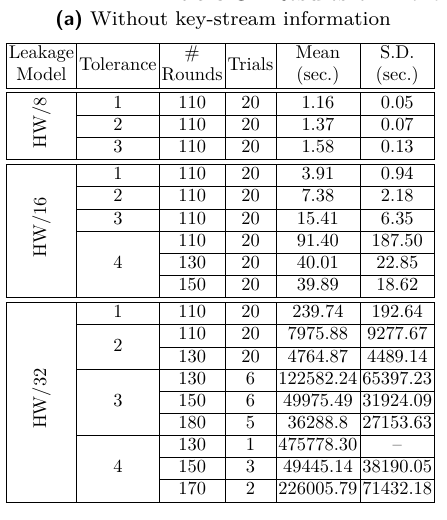
Table 5: Results on TRIVIUM in pseudo-random phase